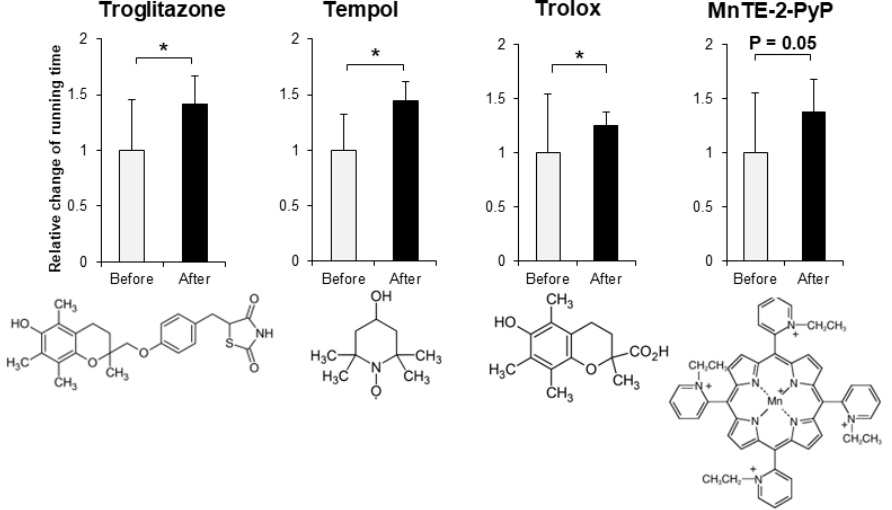
Figure 2. Functional factors that enhance the running activity of muscle- Sod2 -/- mice. Positive effects of functional factors on the treadmill task performance of muscle- Sod2 -/- mice (top) and structural formulas of each compound (bottom). * p < 0.05. Data are shown as the mean ± SD.